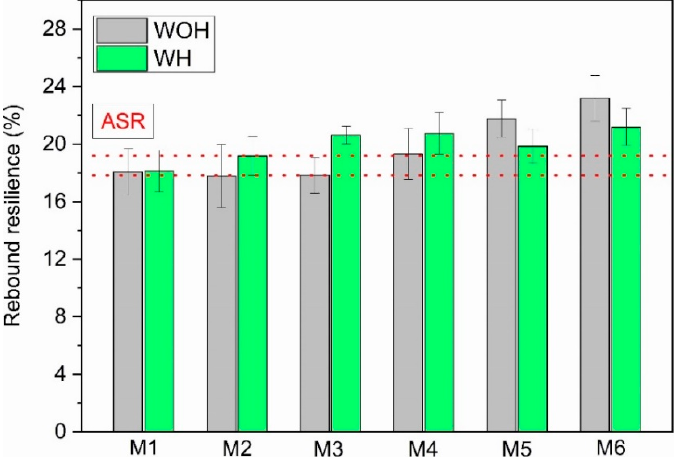
Figure 10. Rebound resilience (R) of ASR-based blends formed without and with homogenization.